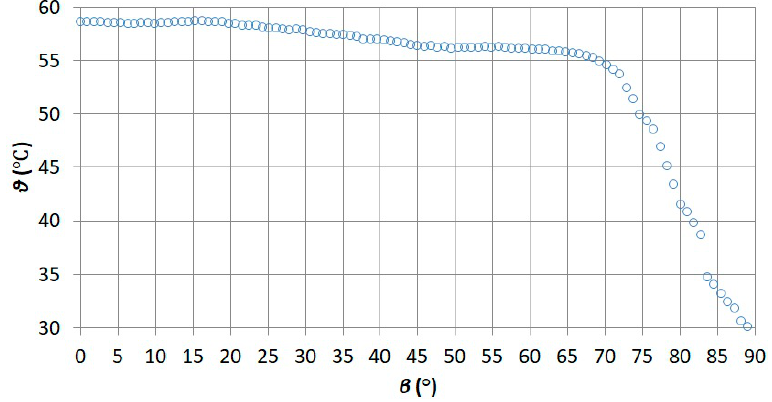
Figure 10. Dependence of the camera indication ϑ on the observation angle β .